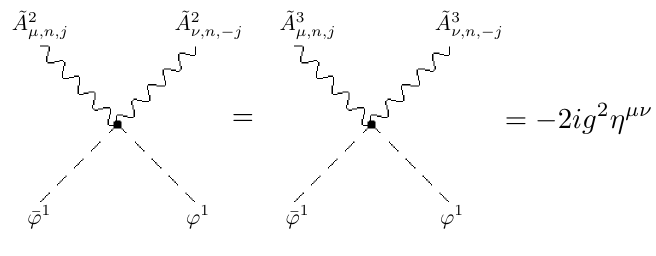
Figure 4 . 4-point vertex for ϕϕAA .